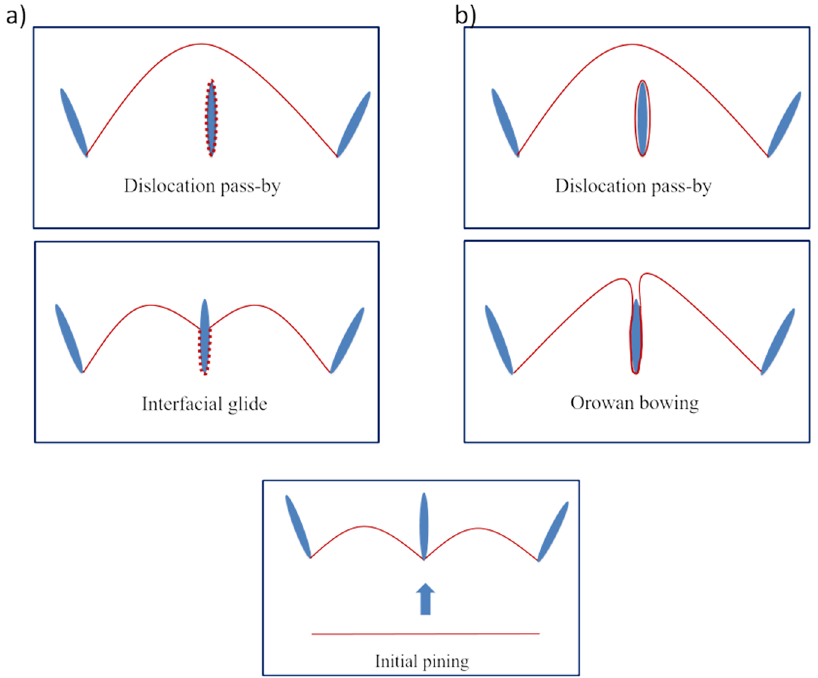
Figure 4. Schematic diagram of ( a ) proposed interfacial glide mechanism and ( b ) classical bowing mechanism for overcoming the given precipitate configuration. The dotted line around the center precipitate is the interfacial dislocation created by forward dislocations. Solid lines represent the initial position, critical condition, intermediate position and final position from bottom to